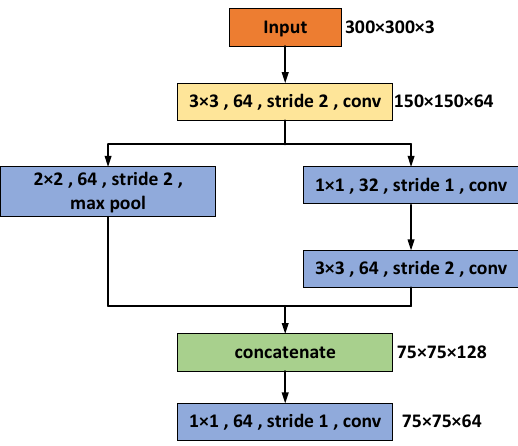
Figure 2. Schematic diagram of stem block.